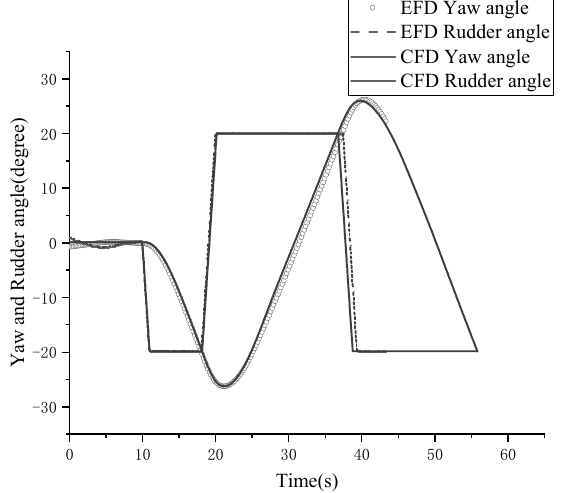
Figure 27. Heading and rudder angle in 20° zigzag maneuver.